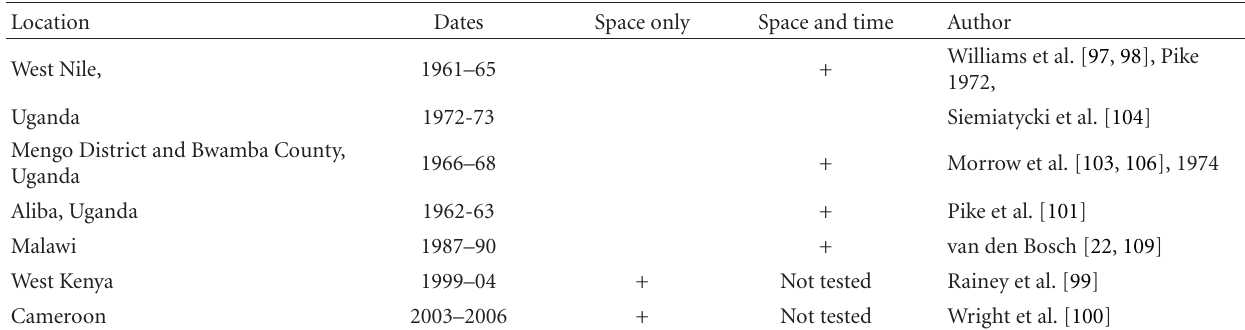
Table 1: Reports of Case clustering in endemic Burkitt’s